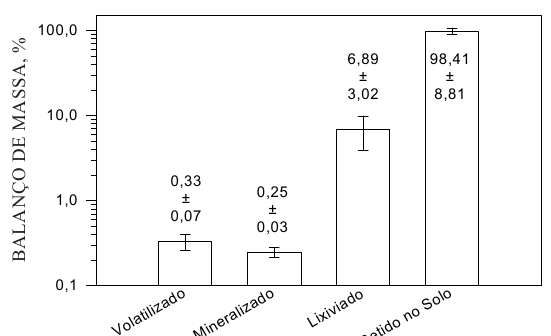
Figura 3. Balanço de massa (média de quatro repetições e desvio-padrão) de 14 C-atrazina aplicada a Argissolo Vermelho-Amarelo após 60 dias de experimento.